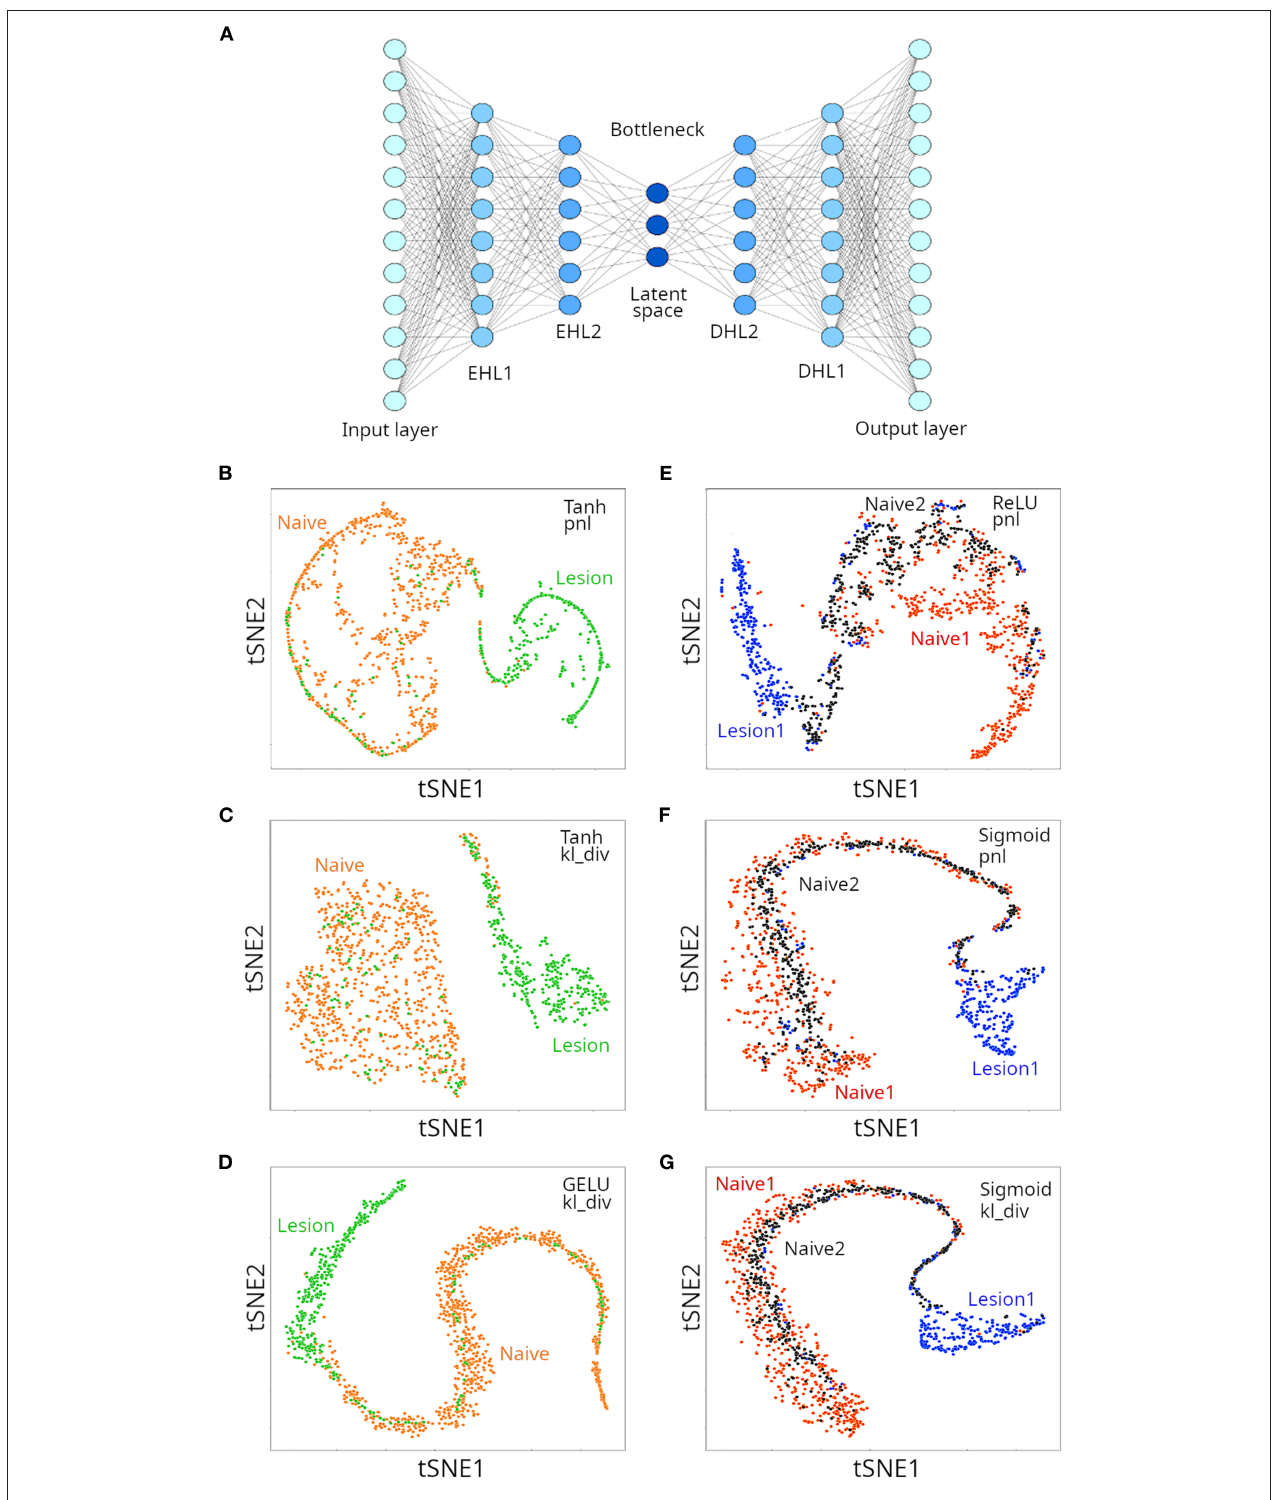
FIGURE 6 | Clustering of microglia single cell transcriptomes using autoencoders. (A) Cartoon depicting an autoencoder neural network. When aiming at discriminating between two clusters, we used Tanh (B,C) and GELU (D) as activation functions for hidden layers, and either Poisson NLL (pnl) (B) or Kullback Liebler divergence (kv_div) (C,D) loss functions. When aiming at discriminating between three clusters, either ReLU (E) , or sigmoid (F,G) were used as activation functions. Loss functions are also indicated (E–G) .